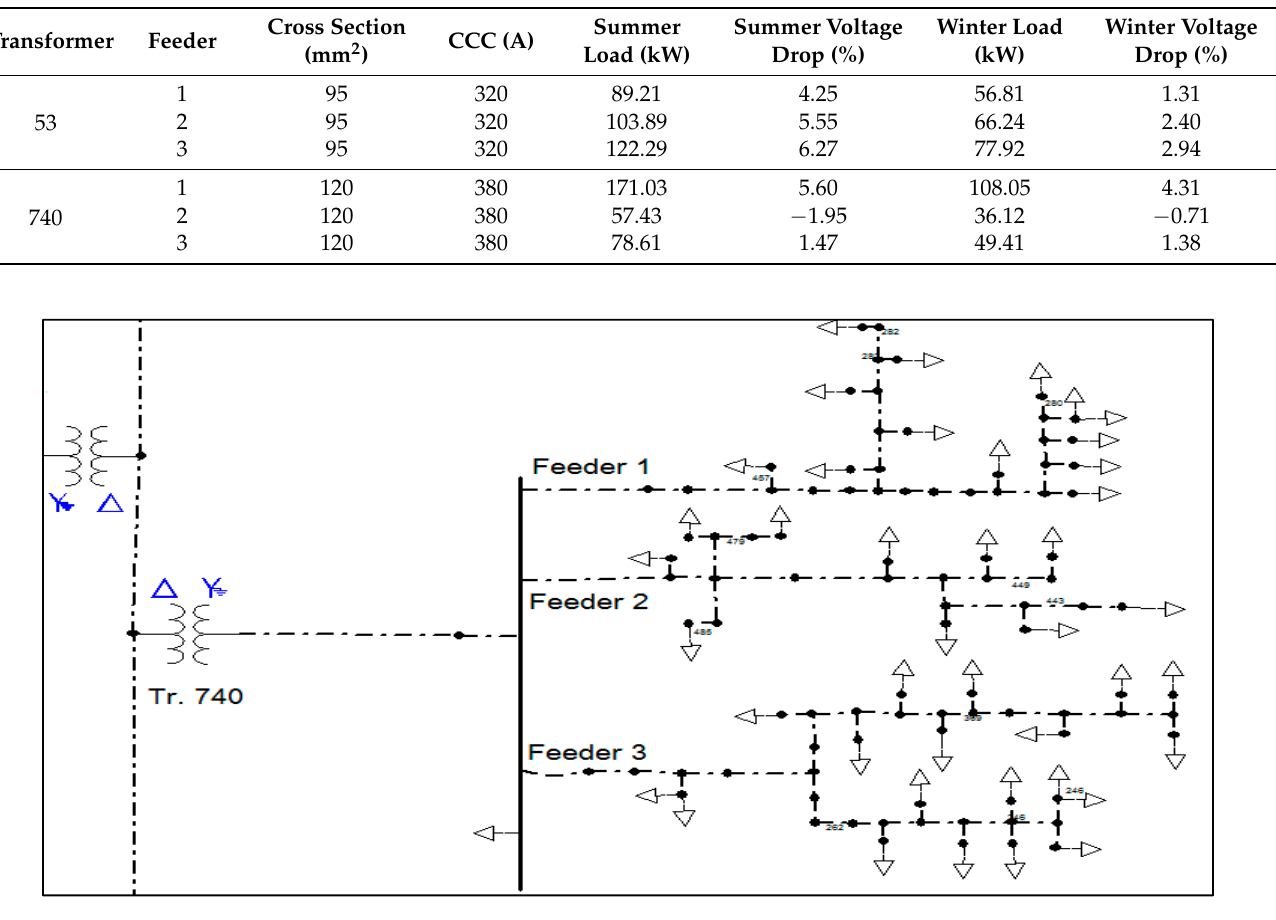
Table 3. Network data of block No. 1 in Aqaba.